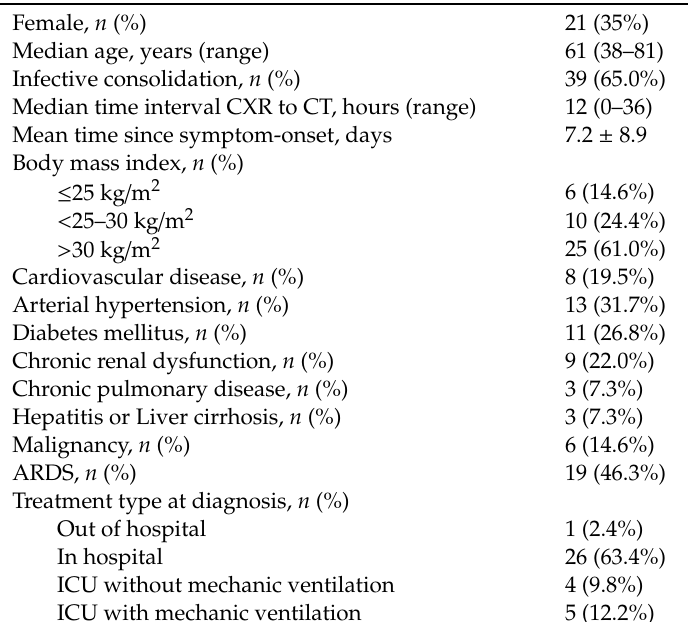
Table 1. Clinical characteristics of study